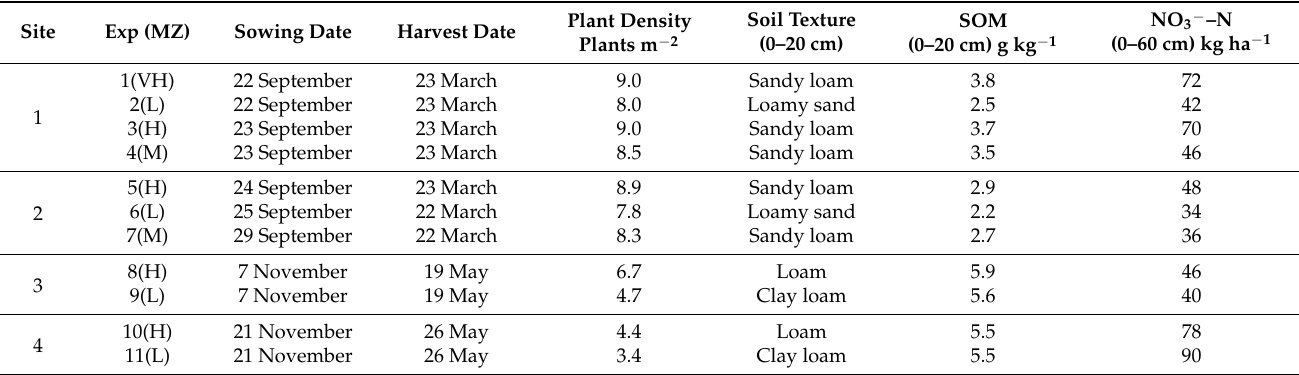
Table 1. Corn management characteristics (sowing and harvest date, plant density), soil texture, soil organic matter (SOM), and nitrate–nitrogen (NO 3 − –N) content for 11 experiments.